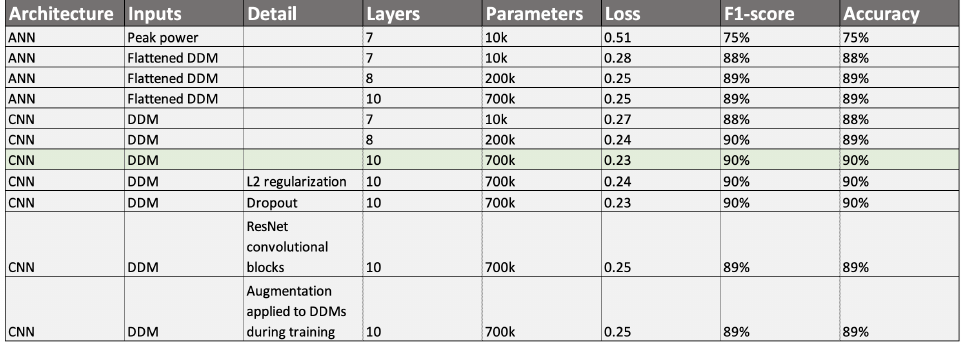
Figure 7. Performance comparison between the ANN with the peak power as input, ANN with the flattened DDM as input, and CNN with the original DDM as input. The networks presented used the same train, validation, and test splits, learning rate (0.0001), and number of epochs (10) to ensure a similar comparison while evaluating differences in inputs and changes in network architecture. The results corresponded directly to the test-data split (approximately 150k observations—5% of 3 m observations). F1-score is provided alongside accuracy due to the slight imbalance in the distribution of bare and forested land classes. The CNN with 700k parameters (highlighted in green) had the best performance in F1-score and accuracy, as well as the lowest